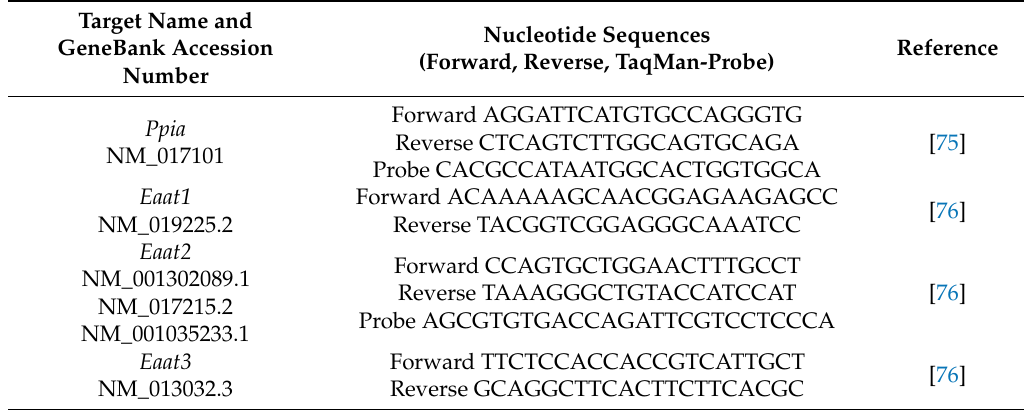
Table 1. Nucleotide sequences of primers and